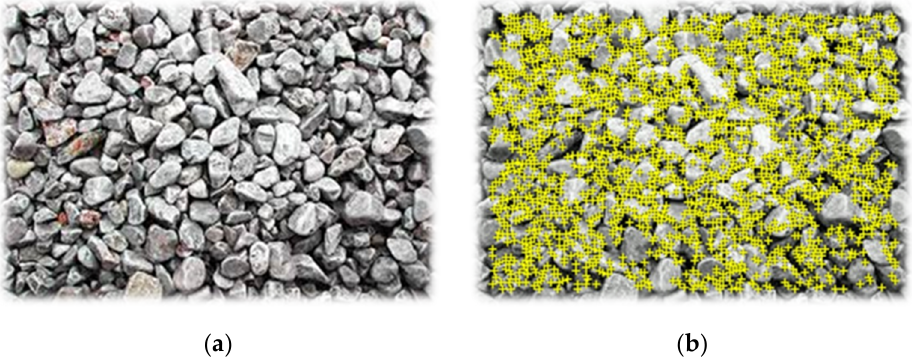
Figure 12. Image Target: ( a ) Image Target used for the application of augmented reality (AR); ( b ) Tracking points recognized on the Image Target used.